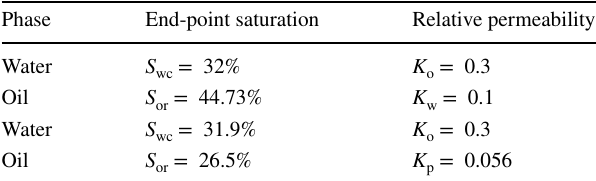
Fig. 15 History matching of oil saturation during polymer flooding Table 8 Relative permeability in end-point saturation of water (up) and polymer (down) flooding